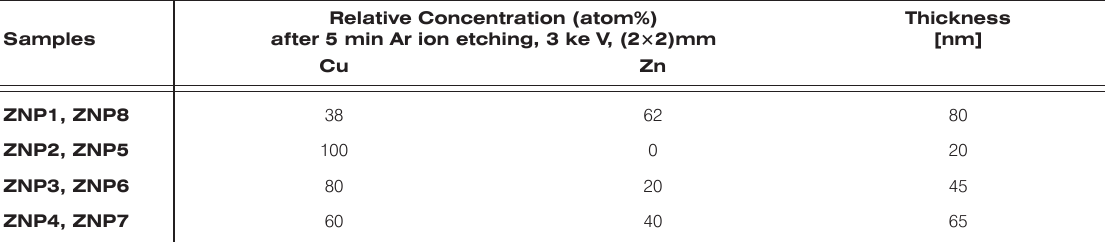
Table 4. Thickness of Ni-Zn-P film at Cu substrate.